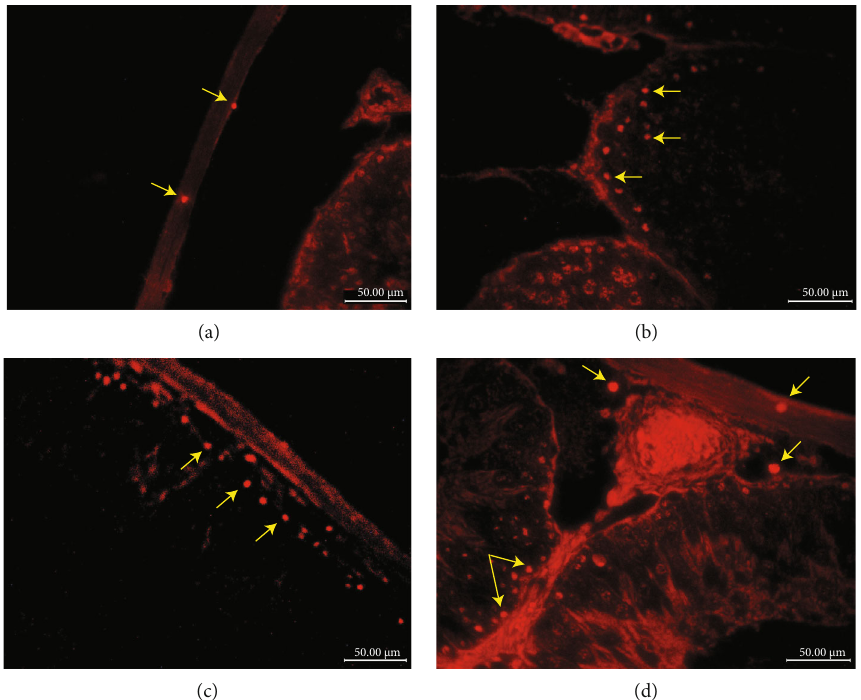
Figure 4: Immuno fl uorescent photos show the fl uorophore of the labelled stem cells in testicular tissue of the ADMSC-treated group. (a, b) Transplanted stem cells in the tunica albuginea (arrows). (c) Fluorophores lining the seminiferous tubules (d) in interstitial tissue